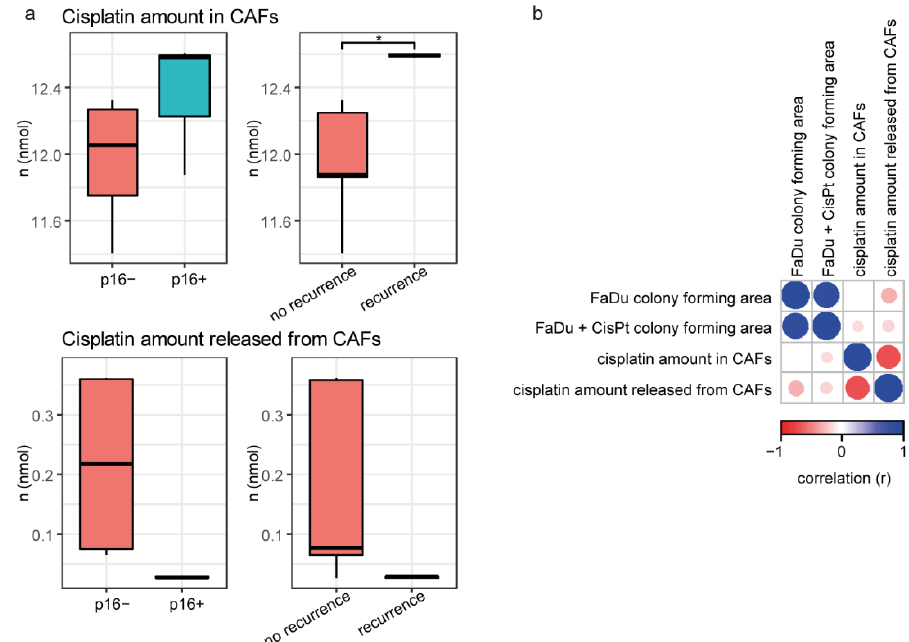
Figure 5. Cisplatin content in media and CAFs. ( a ) Cisplatin amount absorbed from media to CAFs is associated with patient recurrence (higher in CAFs from patients who had a recurrence). Cisplatin amount released from CAFs (CMCAF_post-cisplatin medium) was not associated with p16 status and/or recurrence. ( b ) Correlation heatmap of colony area and cisplatin amount in CAFs and/or cisplatin released from CAFs. Asterisk indicate t-test result with p <